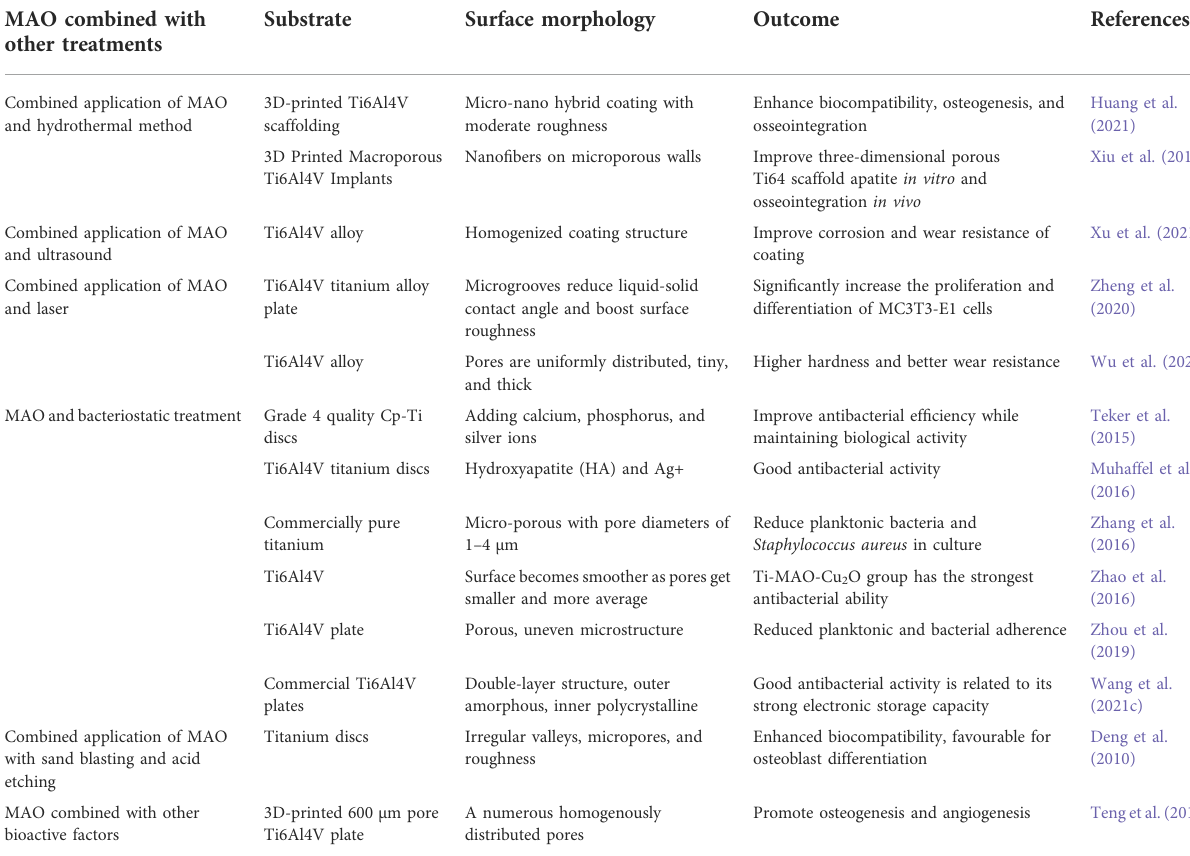
TABLE 3 Combined application of MAO and other treatment methods. MAO combined with other